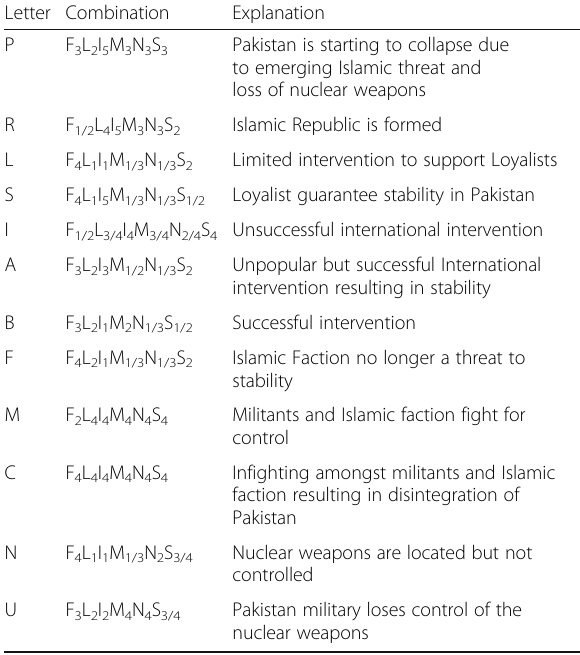
Table 2 List of the final 12 worlds after congruence analysis and combination of like worlds Letter